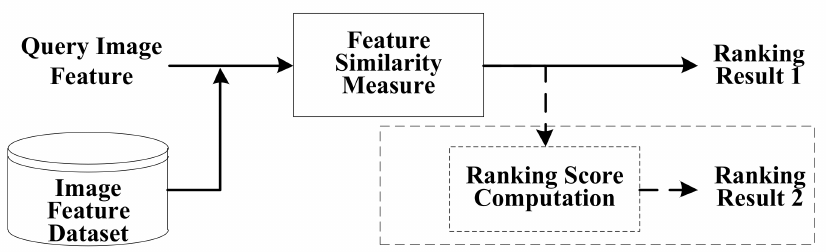
Figure 7. The framework of the similarity evaluation and ranking score computation phase.